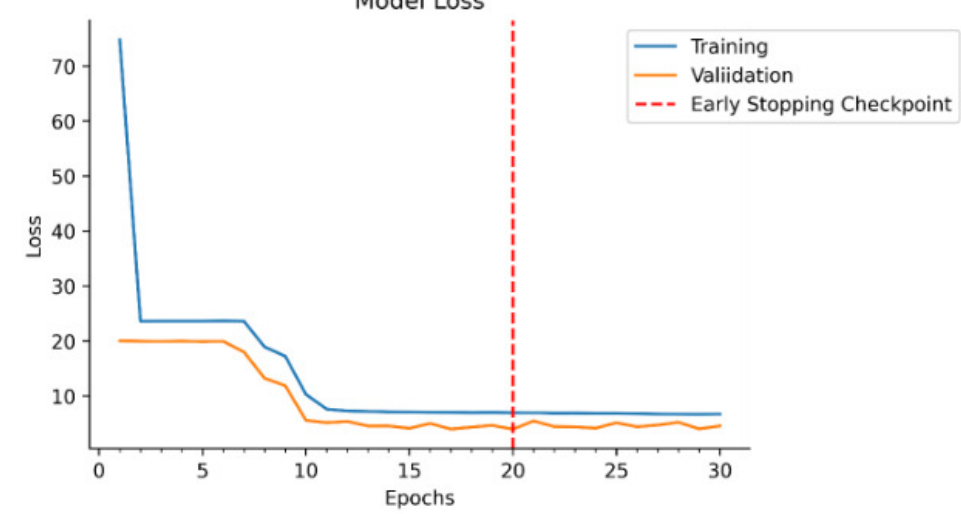
Figure 6. Training and validation loss, or mean square error in model development phase. Early stopping callbacks are used to halt the model if no improvement in loss for a certain number of predefined epochs is